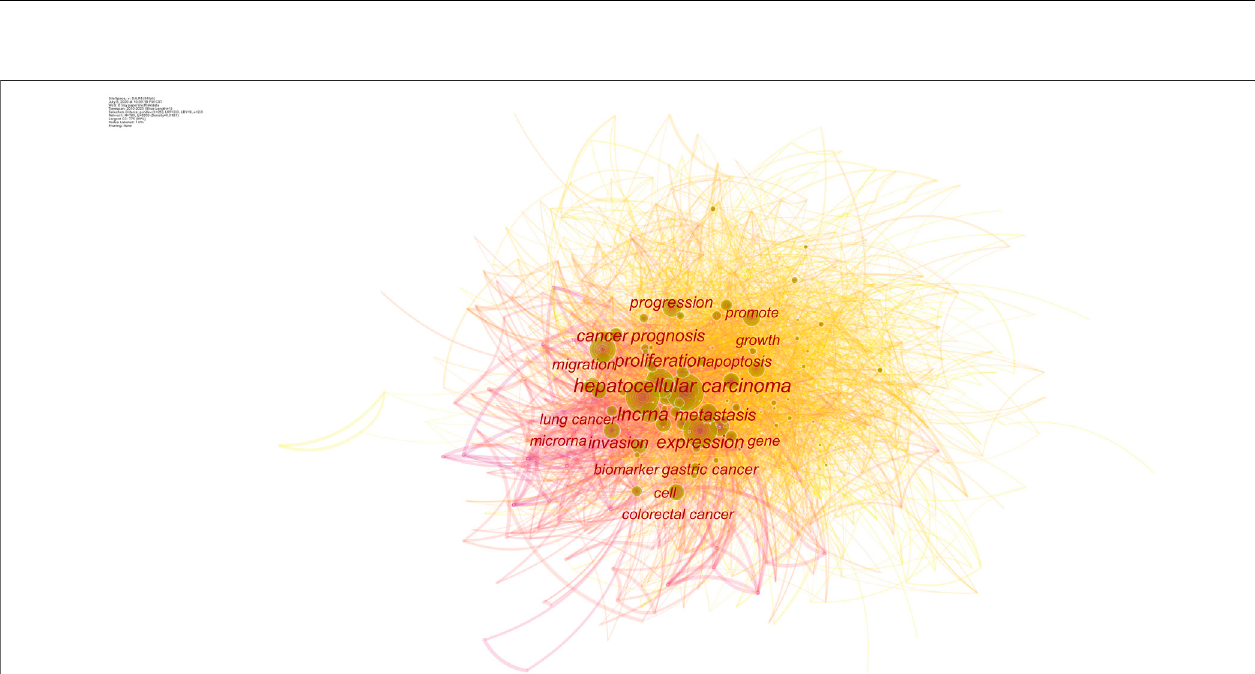
FIGURE 6 | Network map of keywords engaged in the roles of lncRNAs in HCC development research.